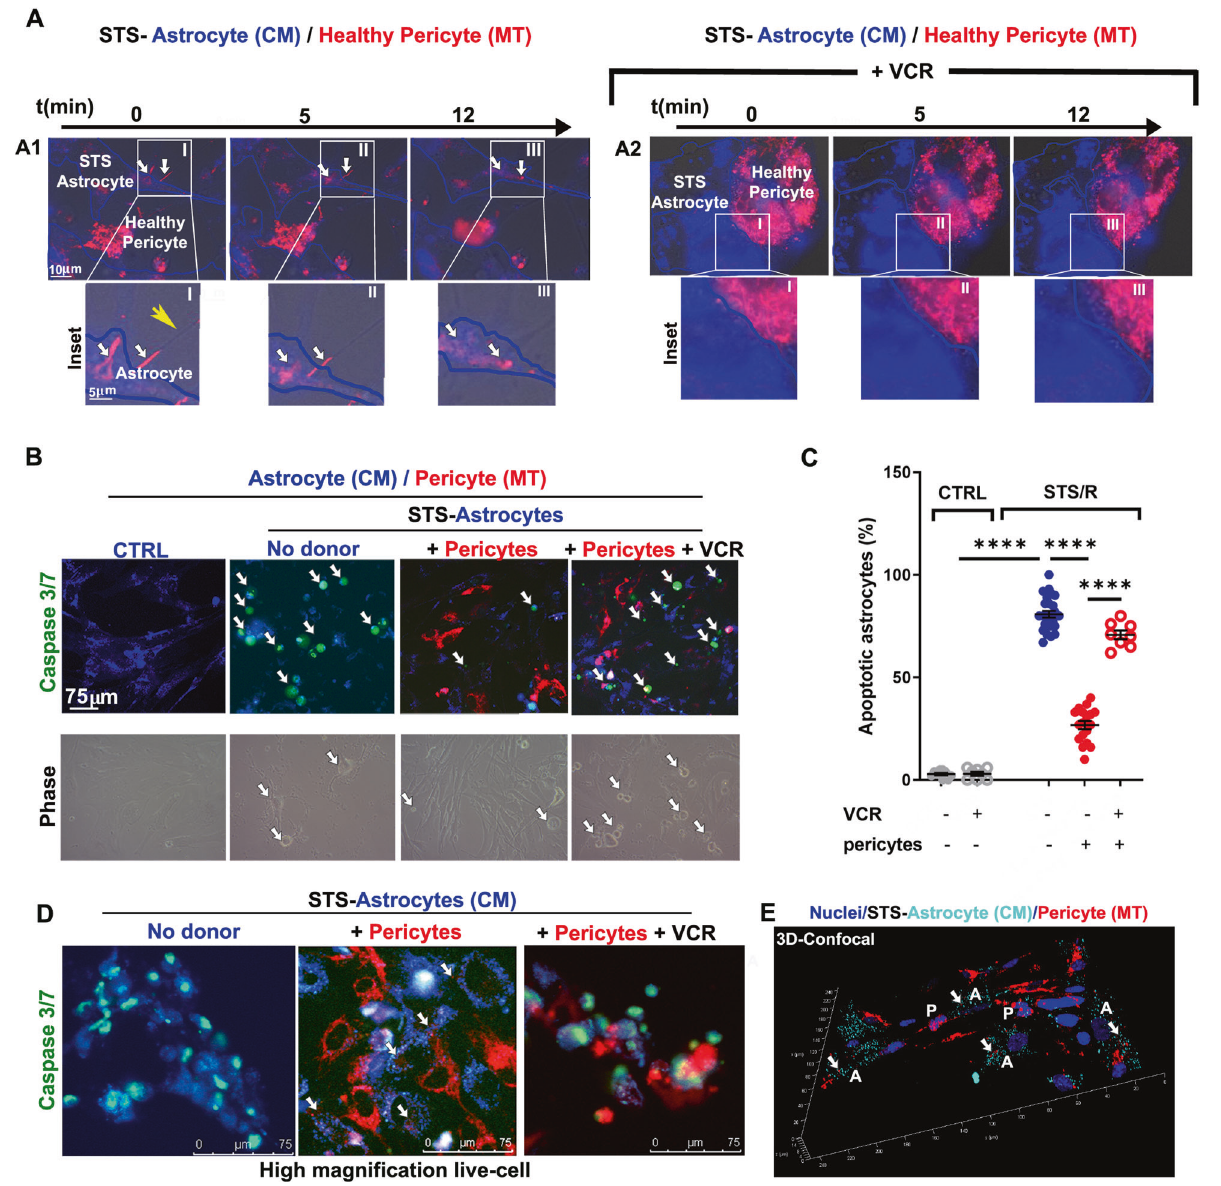
Fig. 7 Pericytes rescue STS-induced astrocyte apoptosis by TNT-mediated transfer of mitochondria. CM-stained astrocytes were incubated with STS for 3 h. After the treatment, cells were washed and co-cultured for 24 h with pericytes ( + Peri) as described in Fig. 6A, in the presence or absence of the tubulin-depolymerizing drug vincristine (VCR; 10 nM). The co-culture was analyzed for mitochondria traf fi cking and apoptosis by time-lapse and confocal fl uorescence microscopy. A Time-lapse analysis of mitochondrial traf fi cking from healthy pericytes to STS-treated astrocytes. White arrows indicate mitochondria actively transported from healthy pericytes to STS-astrocytes through TNT (yellow arrow) (panel A1, insets I-III; Suppl. Movies 14 – 15). VCR treatment prevents TNT formation and strongly reduces intercellular mitochondrial traf fi cking (panel A2, insets I-III; Suppl. Movie 16). Representative images from N = 17 independent experiments with N ≥ 10 areas per experiment analyzed. B Apoptosis of STS-treated astrocytes regenerated for 24 h with healthy pericytes in the presence or absence of VCR. Astrocytes (blue) that were positive for CellEvent Caspase 3/7 (green nuclei, white arrows) were counted under the experimental conditions reported in the images. C Analysis of STS-astrocyte apoptosis. The percentage of Caspase 3/7-positive on the total astrocyte population is shown. Pericytes strongly rescue astrocytes from STS-induced apoptosis, an effect that is signi fi cantly decrease by VCR. D High magni fi cation images of the analysis reported in panel C. Note the presence of pericyte-derived mitochodria (white arrow) inside STS-treated caspase3/7- negative astrocytes. E Confocal analysis and 3D reconstruction of rescued astrocytes after SDS treatment. Note the presence of pericyte- derived mitochodria (white arrow) inside post-STS astrocytes. N = 4 independent experiments. **** p < 0.0001; Student ’ s t-test (control); two- way ANOVA/Tukey ’ s tests